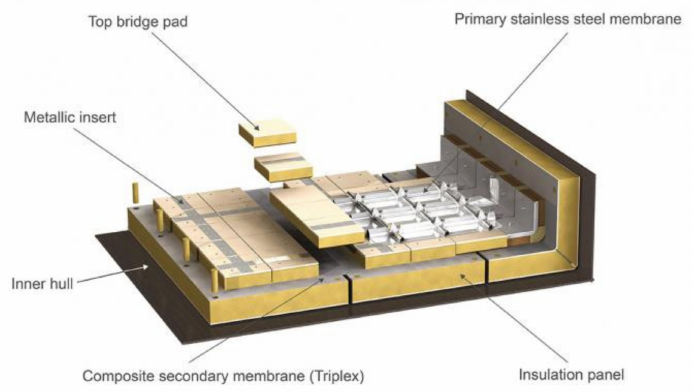
Figure 11. Schematic view of a Mark III type LNG insulation panel [29].